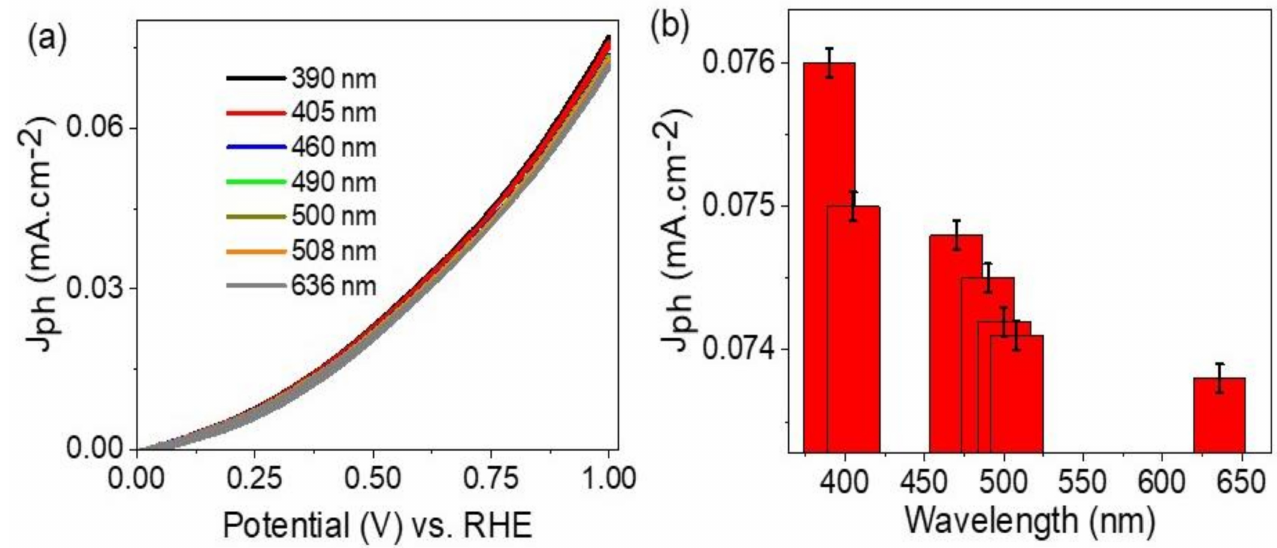
Figure 6. ( a ) The response of the ATO/PANI/PbI 2 photocathode for various light wavelengths.